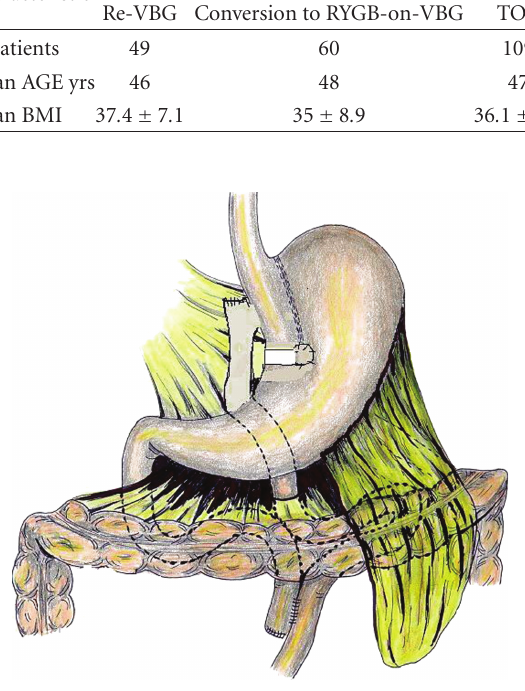
Figure 1: Example sketch of a